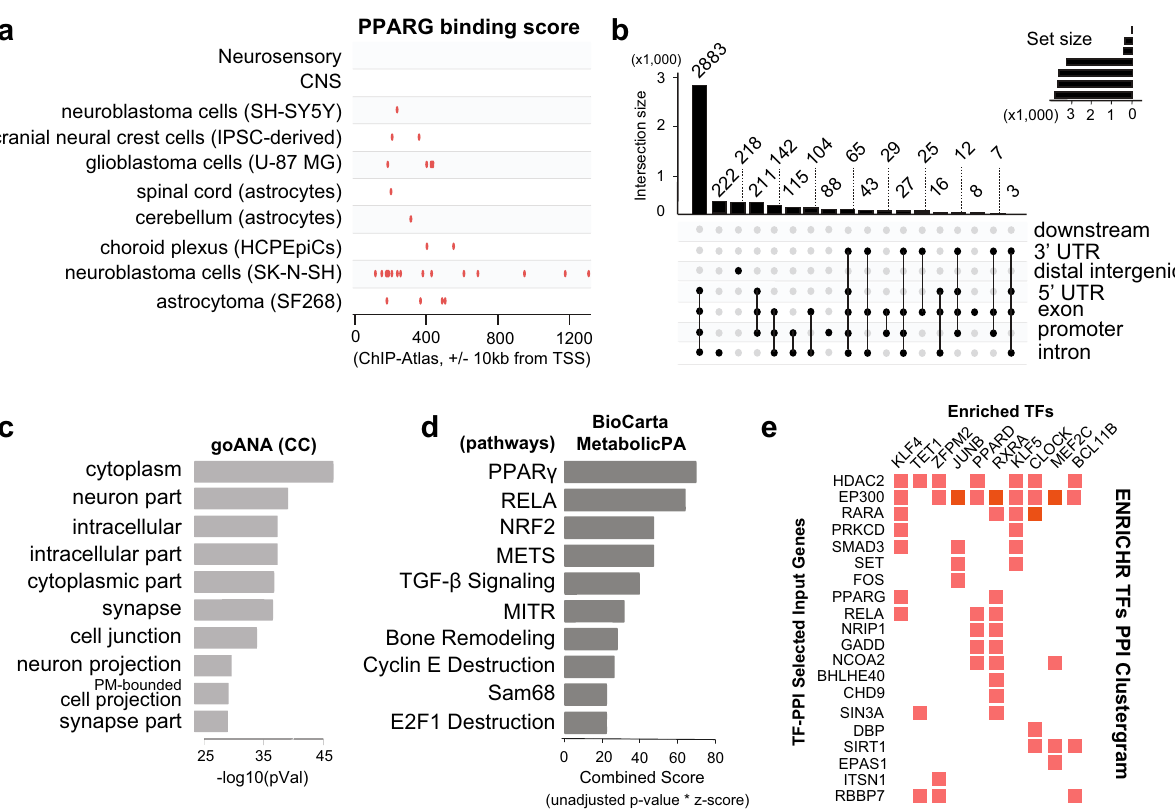
Figure 4 . Characterization of genome-wide PARIS binding sites in SH-SY5Y neuroblastoma cells. ( a ) Human neuroblastoma cells provide a potential niche for PPARγ’s regulatory activities, justifying the choice of cell line for ChIP-seq experiment. ( b ) An upset plot 19 showing the majority of significant PARIS ChIP-seq peaks overlap promoter region (− 3000, + 3000) of the genes in the human genome. ( c ) Enrichment of neuron- specific cellular components by PARIS taking the entire set of the peak-annotated genes as input. ( d ) Enriched metabolic pathways identified by BioCarta MetabolicPA module in EnrichR 27 taking as input the significant peak-annotated genes that are also ranked by fold enrichment and that have a ChIP-seq peak overlapping the promoter region. Top 3 pathways include PPARγ and NRF2 pathways. ( e ) Enriched TFs identified by Transcription Factor PPI module in EnrichR 27 taking the same genes in ( d ) as input. The most enriched TFs include PPAR